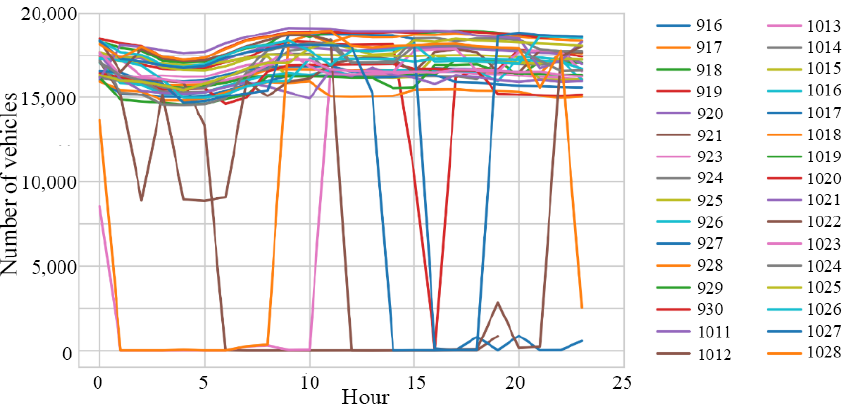
Figure A2. Period characteristics of the number of vehicles.